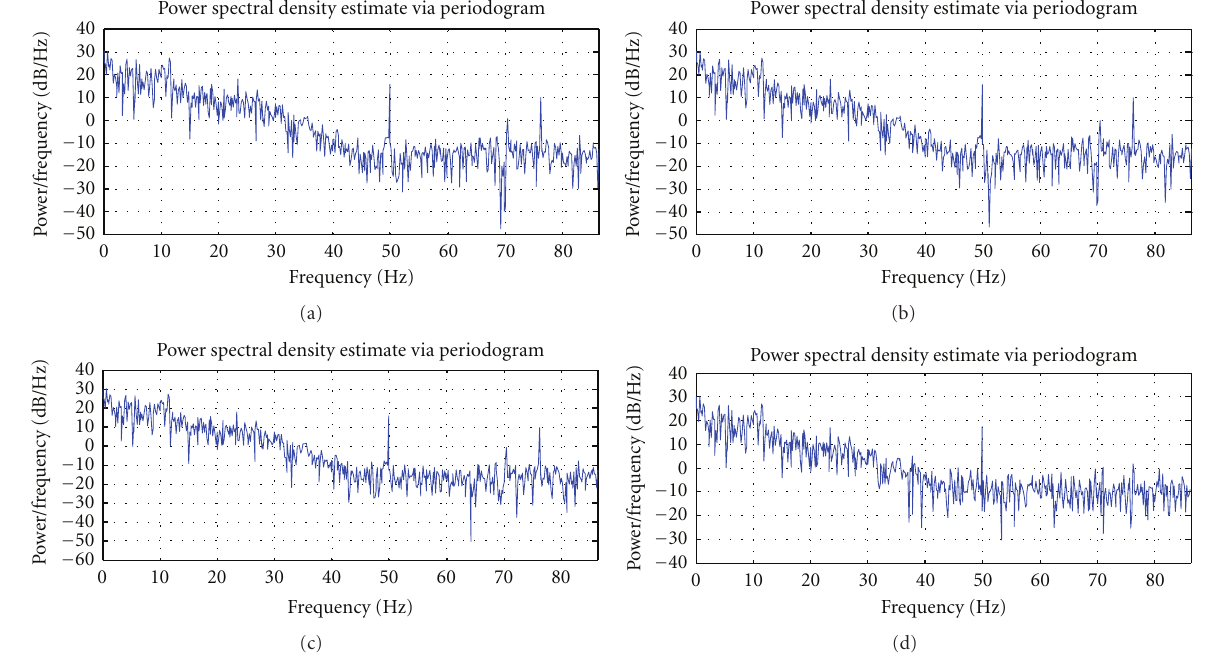
Figure 12: Power spectra of EEG dataset3: (i) Original signal, (ii) reconstructed signal at T = 5 at Q1, (iii) reconstructed signal at T = 3 at Q2, and (iv) reconstructed signal at T = 3 at